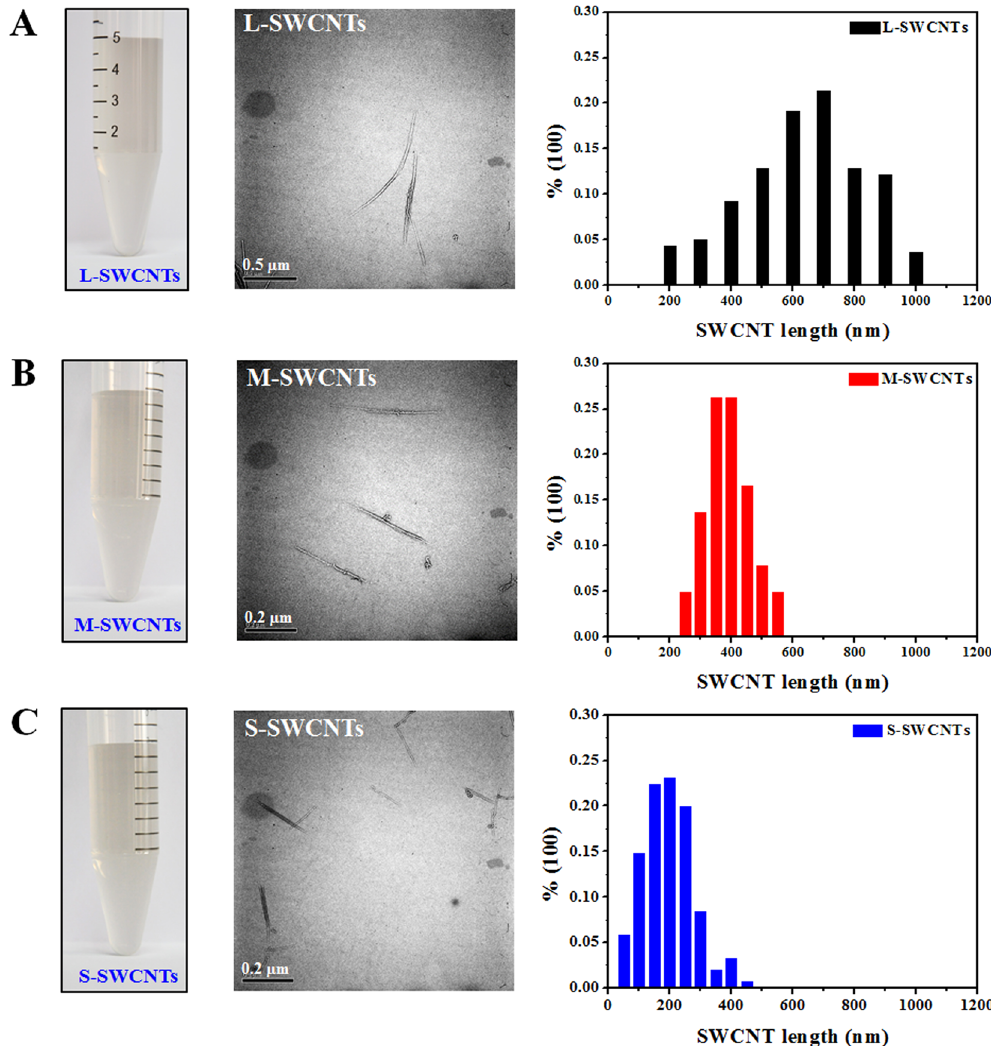
Figure 1. SWCNTs suspensions, TEM images, and length distribution. Stable suspensions(Left), typical TEM image (Middle), and length distribution (Right) of ( A ) L-, ( B ) M-, and ( C ) S-SWCNTs. Length distribution histograms of L-, M-, and S-SWCNTs were generated by measuring approximately 100 individual nanotubes in representative TEM images. In TEM images, the scale bars represent 0.5 µ m for L-SWCNTs and 0.2 µ m for M and S-SWCNTs.